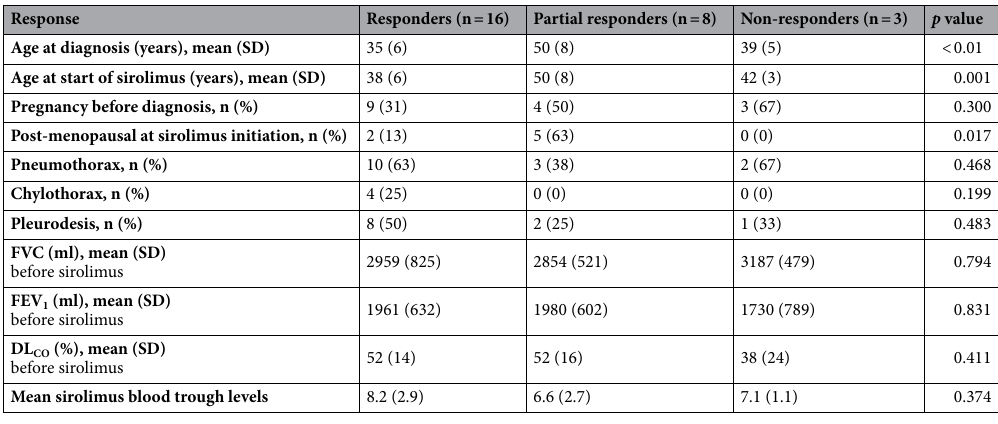
Table 2. Patient’s characteristics according to sirolimus response at 5 years. IQR interquartile range, SD standard deviation.